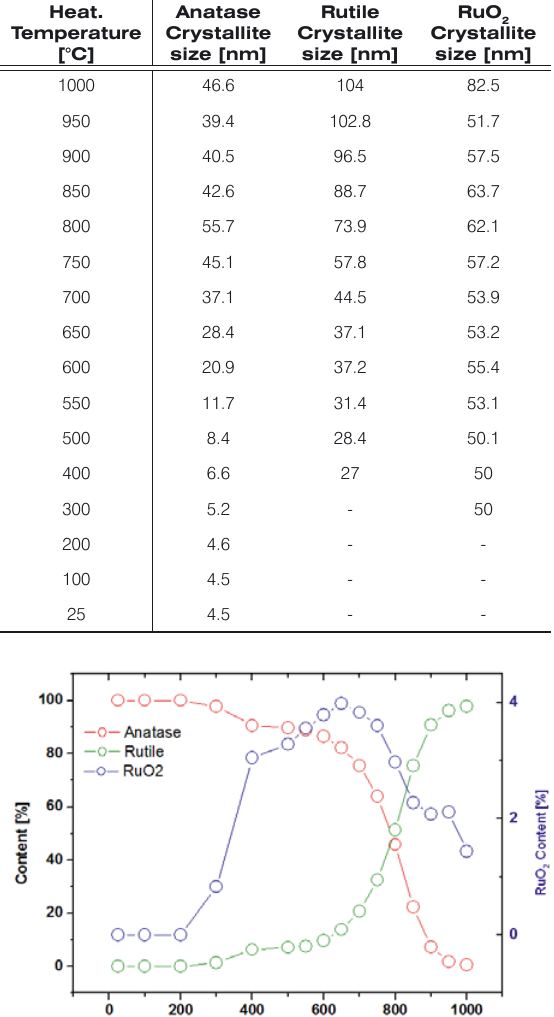
Table 1. Crystallite sizes of anatase, rutile and RuO sample TiRu1 (determined by XRD). Heat. Temperature